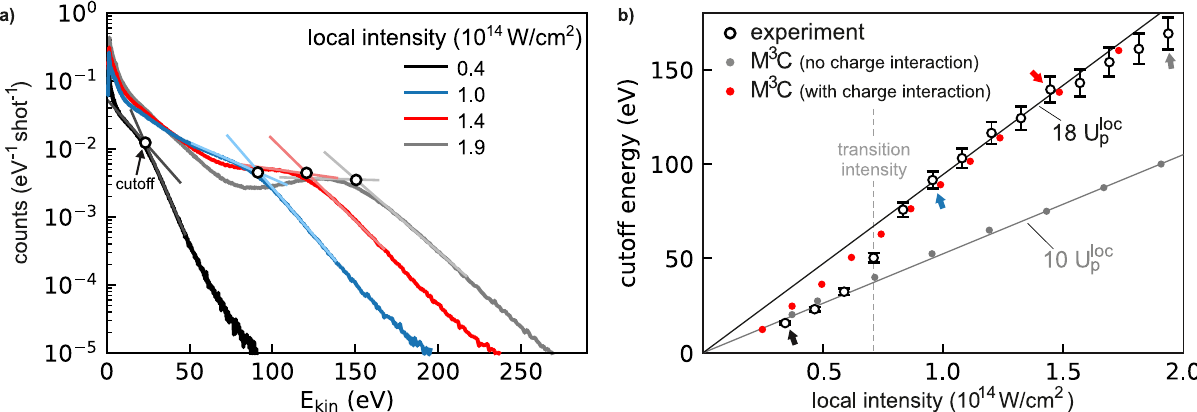
Figure 3: Impact of charge interaction on the cutoff energies of recollision electrons emitted from a tungsten nanotip: (a) CEP-averaged electron energy spectra for different local intensities (as indicated). The cutoff energies are defined via the intersection of linear fits of the data below and above the apparent cutoff of the respective recollision plateaus. (b) Cutoff energies as a function of near-field intensity (black circles). Colored arrows indicate the cutoffs corresponding to the spectra in (a). Gray and red symbols show the cutoffs extracted from semi-classical M 3 C simulations performed for the experimental parameters when ex- and including charge interaction, respectively. Gray cutoff law as expected from the simple man’s model and a rescaled 18 U loc cutoff law. The scaling factor and black lines visualize the 10 U loc p p -cutoff law. between input laser power and local intensity is deduced from matching the lowest three experimental cutoff values to the 10 U loc p The vertical dashed line indicates the transition intensity of 7 . 5 × 10 13 W ∕ cm 2